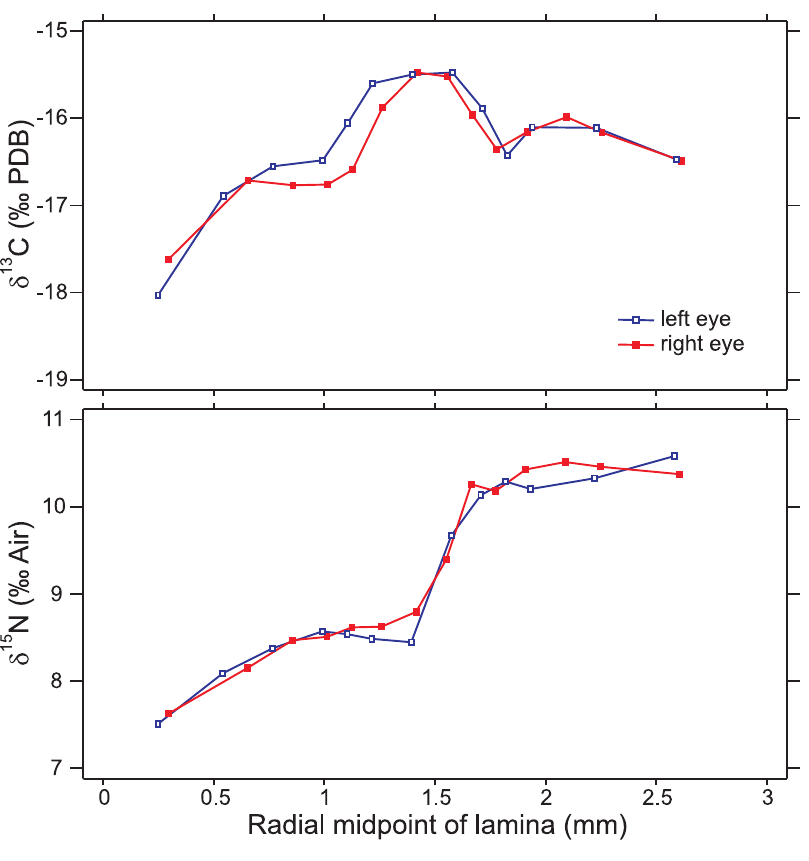
Figure 3. High-resolution comparisons of left and right eyes of white grunt specimen 2.